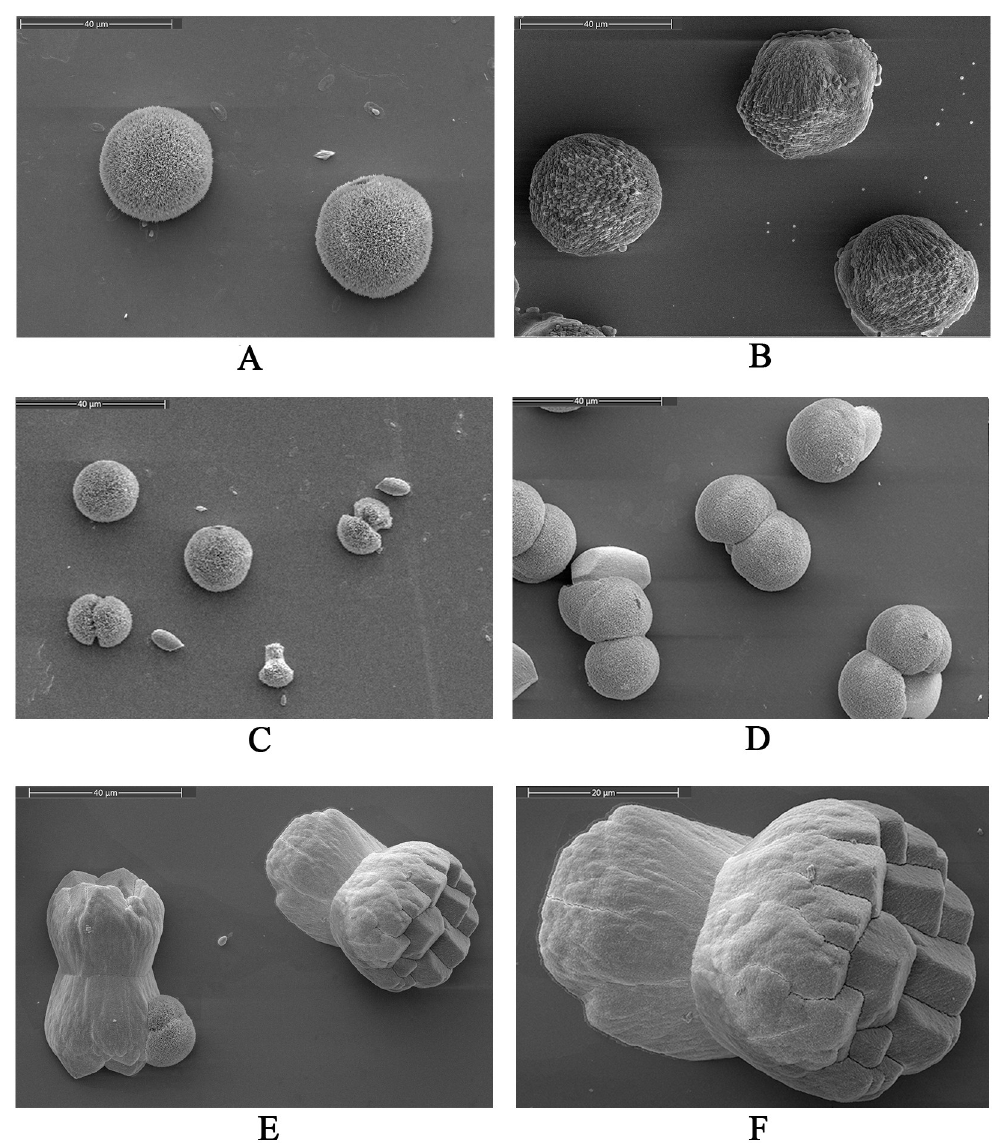
Fig 6. SEM images of in vitro aragonite crystallization in the presence of rWLP at increasing concentrations. A: aragonite crystals without protein induction. B: aragonite crystals grown with 50 μ g/mL BSA. C: aragonite crystals grown with 10 μ g/mL rWLP. D: aragonite crystals grown with 30 μ g/mL rWLP. E: aragonite crystals grown with 50 μ g/mL rWLP. F: enlarged image of E. were presented, the sequences from flatworm and the sequences from the shell-forming mol- luscs (also known as the conchiferans, including bivalves, scaphopods, gastropods and cepha- lopods). The clade of WLP ( M . coruscus ) was located between Crassostrea and Mizuhopecten , indicating the conservation of this protein among bivalves. As one type of PDCP, WLP has 147 residues, of which Gln is the most abundant amino acid (9.5%) in its sequence, followed by Gly (8.8%) and Arg (8.2%) (S2 Table). SMPs rich in Gln have been found in various Mol- lusca shells, such as those of Pinctada margaritifera [33], the gastropod Lottia [34], Unionidae Elliptio complanata , and Villosa lienosa [35]. Interestingly, vertebrate teeth also contain Gln-